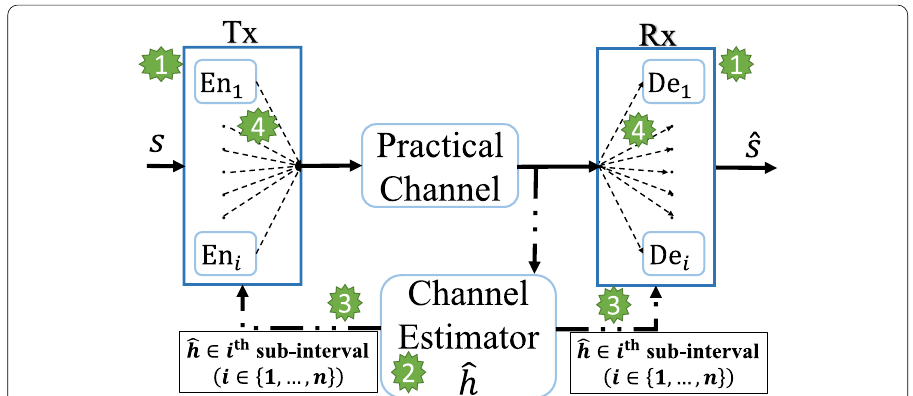
Fig. 2 Four-step structure of the proposed adaptive transmission scheme for the DL-based communication